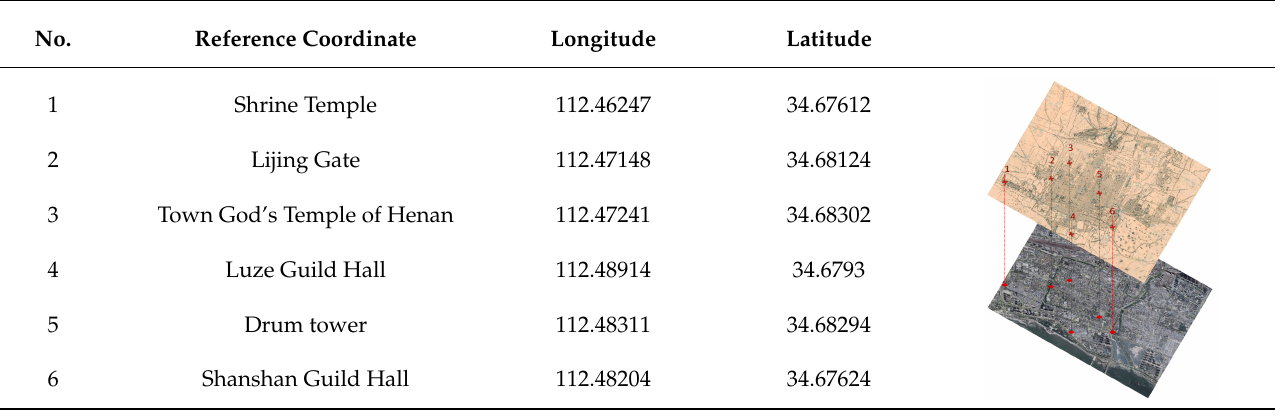
Table 1. Historical maps and satellite image of Luoyang.